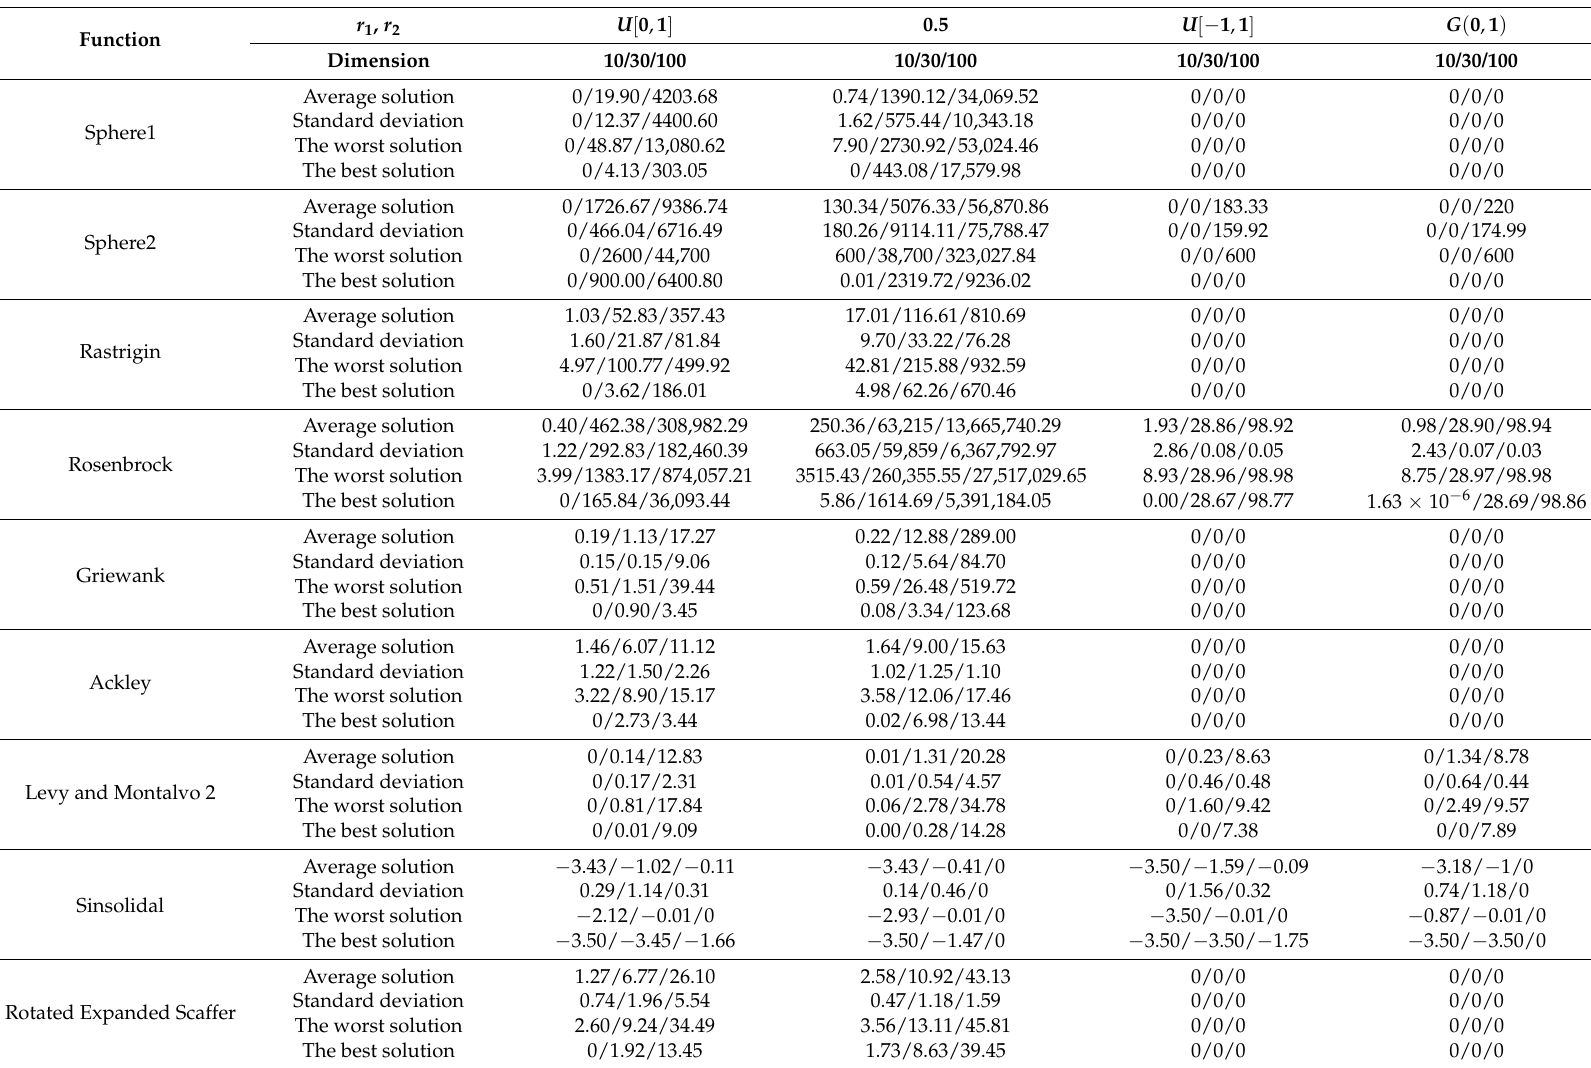
Table 2. Comparisons of standard particle swarm optimization (PSO) algorithm with different types of random values for benchmark